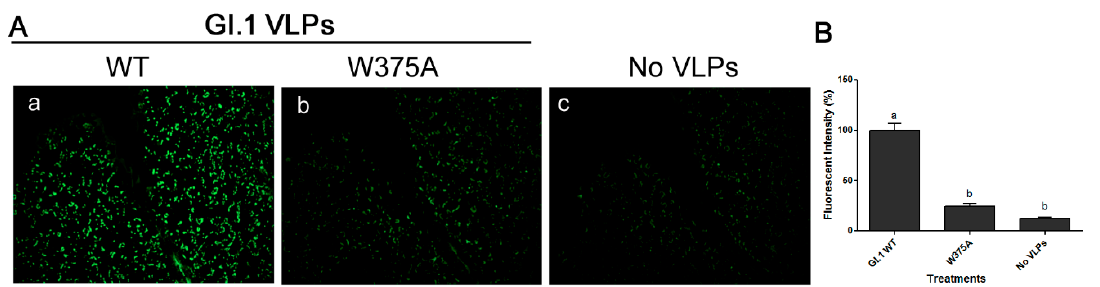
Figure 6. ELISA showing the binding of HuNoV GI.1 WT VLPs and its mutant W375A VLPs to ( A ) PGM and ( B ) lettuce CWM. Means with different letters differ significantly.